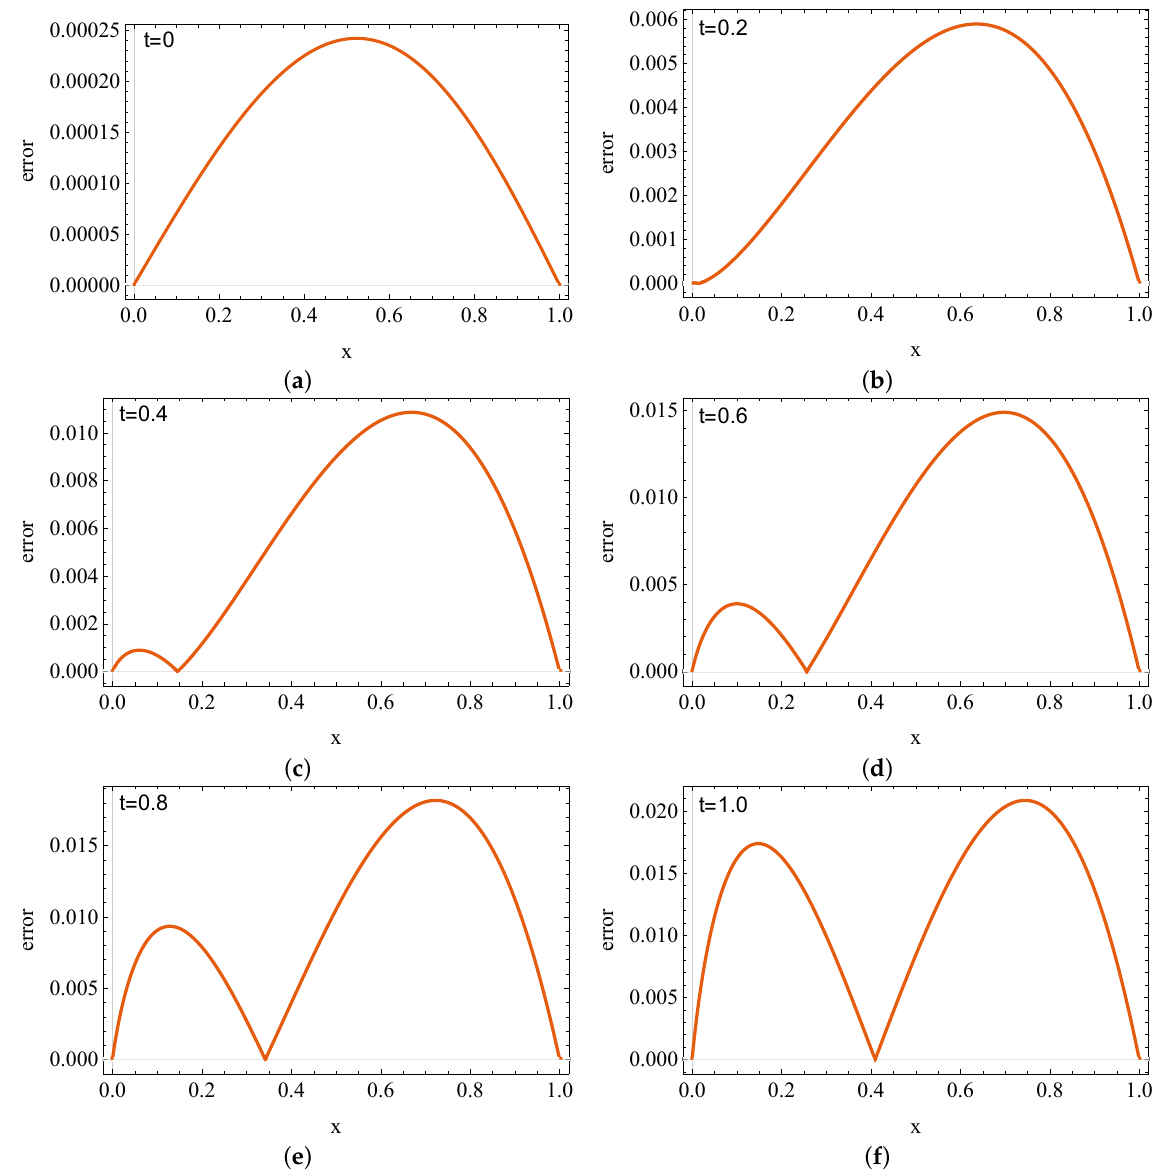
Figure 4. Errors | u e ( x , t ) − (cid:98) u 10 ( x , t ) | for differnt times: ( a ) t = 0, ( b ) t = 0.2, ( c ) t = 0.4, ( d ) t = 0.6, ( e ) t = 0.8, ( f ) t =